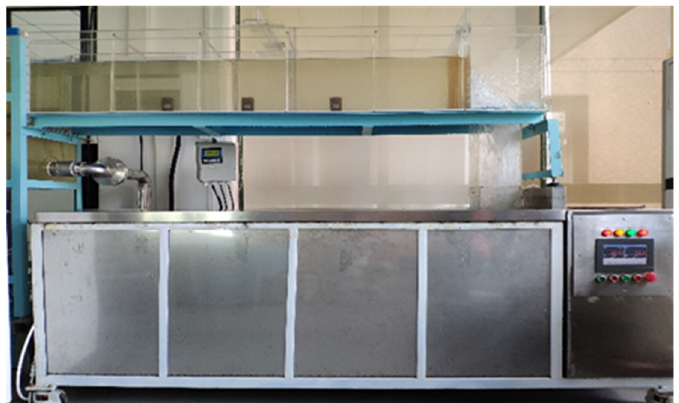
Figure 2. Physical image of multifunctional open channel hydraulics test equipment.